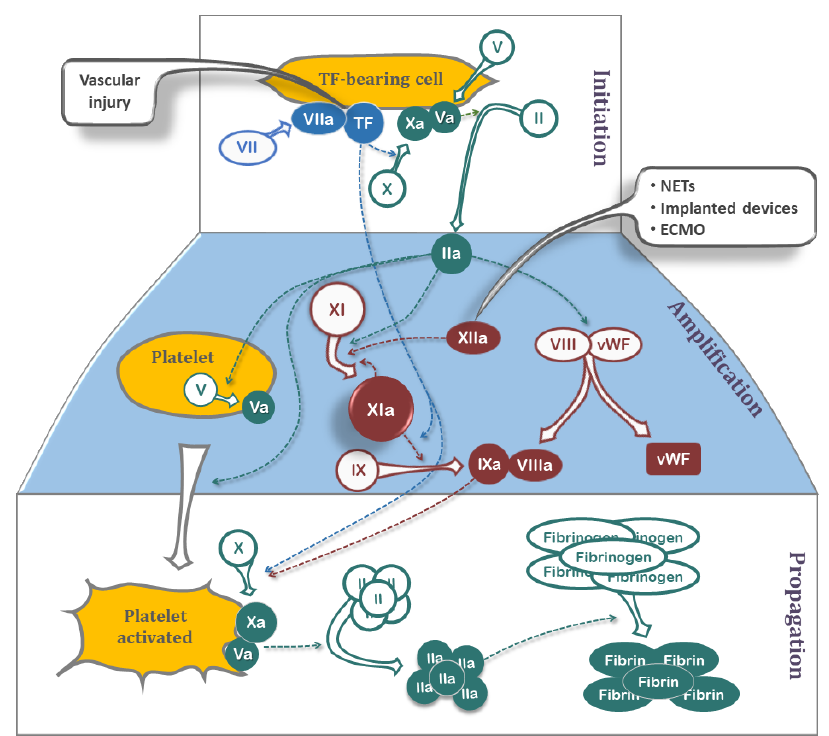
Figure 2. Cell-based coagulation model illustrating the Initiation, Amplification, and Propagation of the coagulation process. In the initiation phase, a small amount of thrombin and FIXa is generated on the surface of the tissue factor (TF)-bearing cell that then diffuse away towards platelets. In the amplification phase, this thrombin activates platelets (releasing factor Va from α granules), acts on vWF-VIII to release vWF and activated factor VIIIa, and generates activated factor XIa. The role of factor XI/XIa is primarily in the amplification stage where it activates factor IX and, in a feedback loop, promotes further activation of zymogen factor XI to active factor XIa. The propagation phase involves assembly of the various enzymes generated earlier to advance the process towards fibrin generation and clot formation. Components of the classic TF-, contact- and common-pathway are shown in blue, dark red, and green, respectively, along with triggers (black boxes) for each pathway. Selective modulation of the contact pathway theoretically should lower the risk of thrombosis without increasing bleeding. Development of drugs that act by inhibiting components of the contact pathway is currently in high gear, with factor XI (FXI), and to a lesser degree factor XII (FXII), being the most prominent targets [34–36]. Evidence from epidemiological studies supporting their role in thrombosis is stronger for FXI than it is for FXII [37]. 4. Factor XI as a Therapeutic Target Factor XI is a blood coagulation zymogen produced by the liver that is part of the early phase of the contact pathway [38]. It is converted to the active serine protease FXIa by thrombin, FXIIa, and by FXIa itself and in turn activates FIX to further advance the coagulation process [38]. FXI plays an important part in blood coagulation because its feedback activation amplifies in vivo thrombin generation and fibrin formation [39]. The additional thrombin formed via the FXI feedback loop also promotes the activation of Thrombin Activatable Fibrinolysis Inhibitor (TAFI), which increases the clot’s resistance to fibrinolysis, thereby helping to stabilize the formed clot. The greater role of FXIa in thrombosis compared to hemostasis is evident from sev- eral epidemiological and genetic studies. Higher levels of circulating FXI levels are